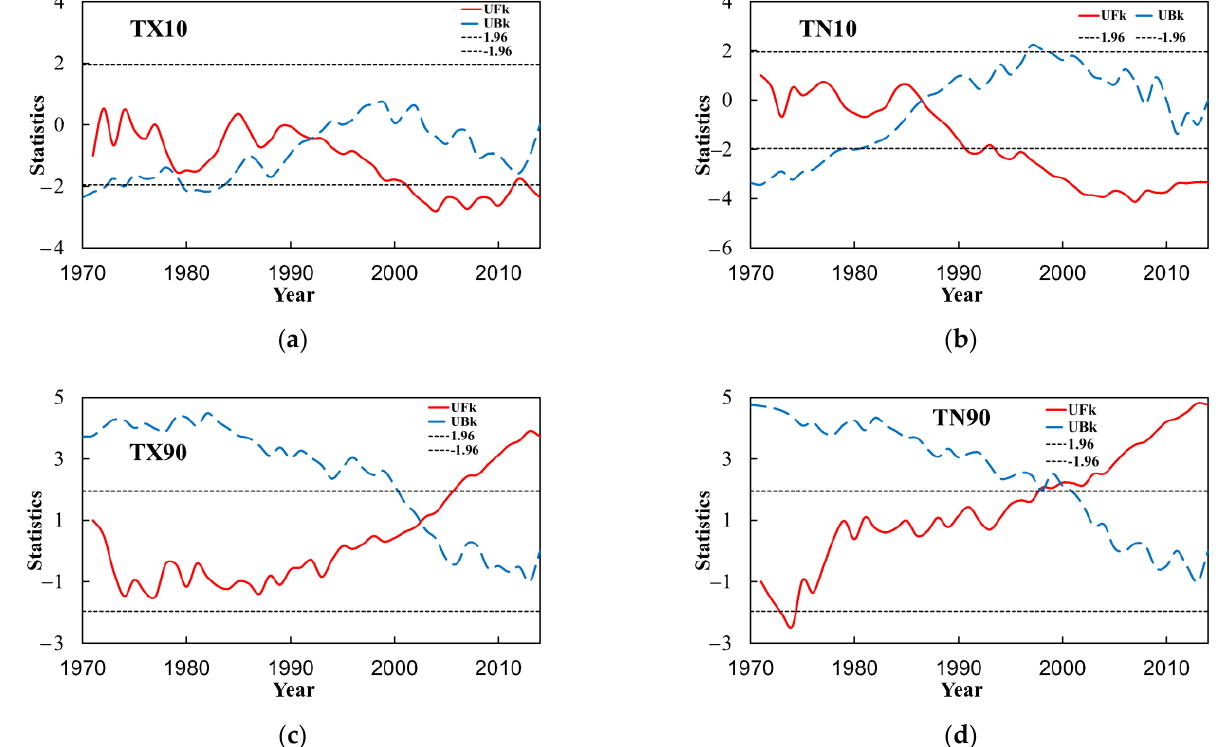
Figure 8. M – K abrupt change test of the relative temperature indices of the Yangtze River Basin from 1970 to 2014. (a) is TX10, (b) is TN10, (c) is TX90 and (d) is TN90.